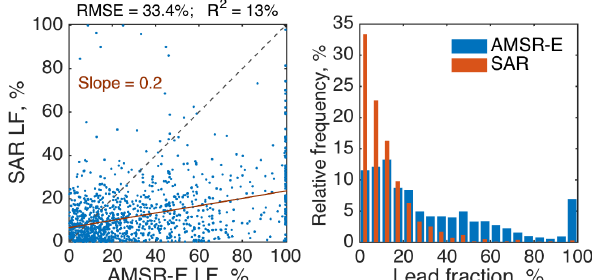
Figure 5. A comparison of the AMSR-E lead fraction (LF) and SAR LF with manual quality control (MQC); the total number of measurements is 1645. Left: scatter plot of MQC SAR LF vs. AMSR-E LF (%). The 1-to-1 line is the dashed grey line, and the linear regression is shown by the red line and the slope value. The root mean square error (RMSE) and the coefficient of determination ( R 2 ) are shown at the top of the plot. Right: histogram for the two data sets shown as a percentage of measurements per each bin of 5% width (relative frequency).